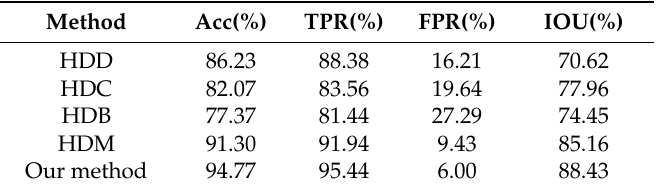
Table 2. Accuracy (Acc), true positive ratio (TPR), false positive ratio (FPR) and intersection over union (IOU) of our method and four competing methods.